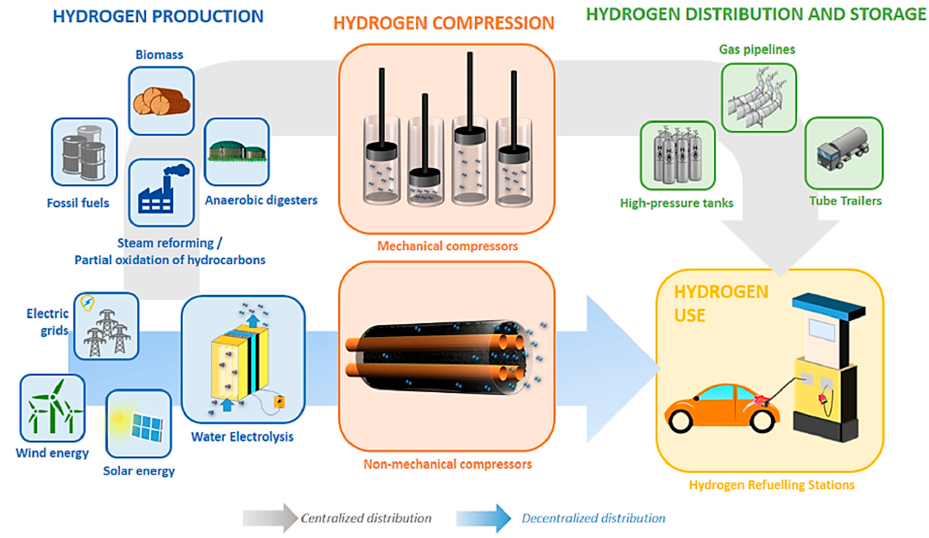
Figure 3. The hydrogen value chain for the specific case of automotive applications.